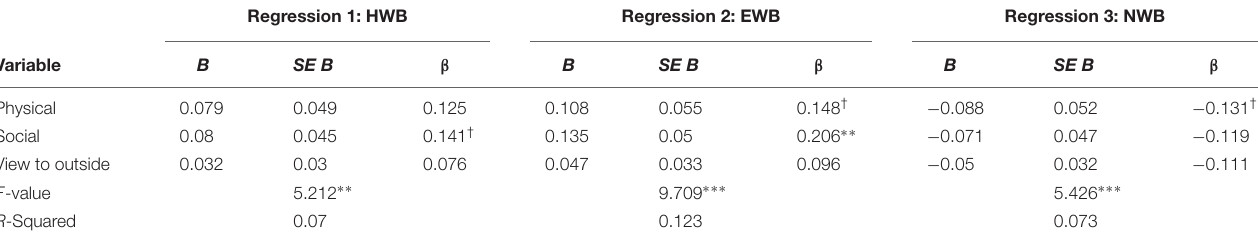
TABLE 4 | Hierarchical Regression analysis of predictors of HWB, EWB, and